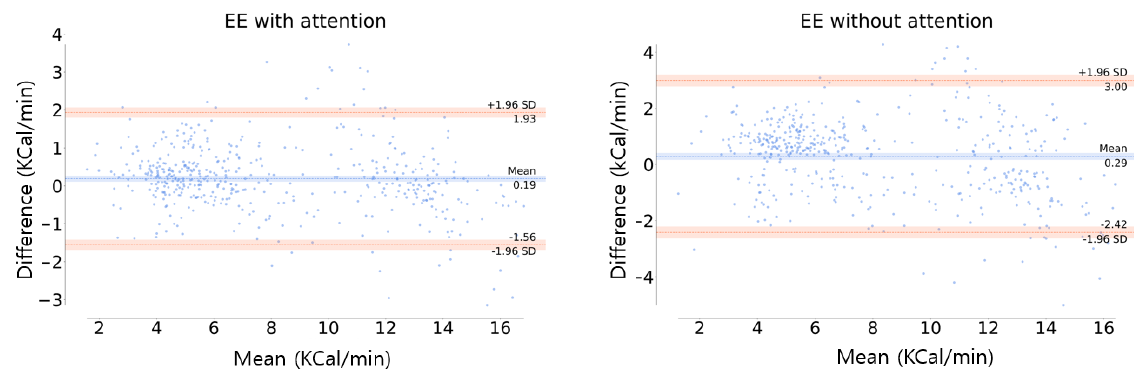
Figure 12. Bland-Altman plot of EE estimation. The orange line is the limit of agreement (LOA) and the center blue line is the mean of difference error between the actual and